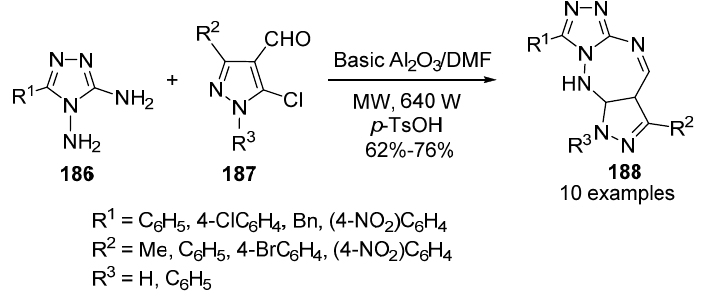
Scheme 36. Green procedure for the synthesis of fused triazepines on a solid support.